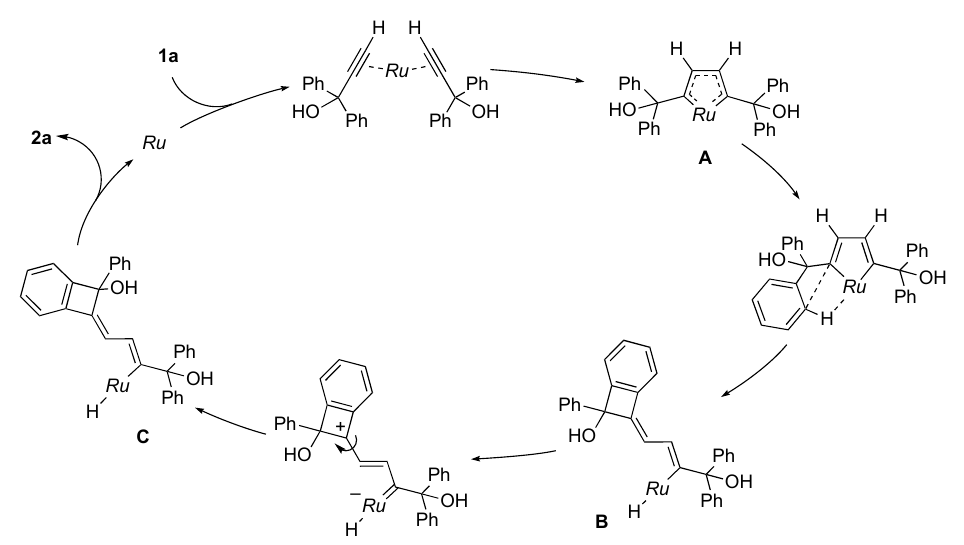
Scheme 4. Proposed mechanism for catalytic dimerization of 1a . Ru = Cp*RuCl.